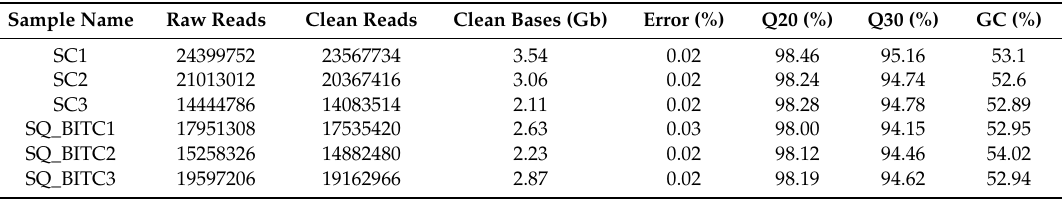
Table 1. Summary of RNA-seq alignment.